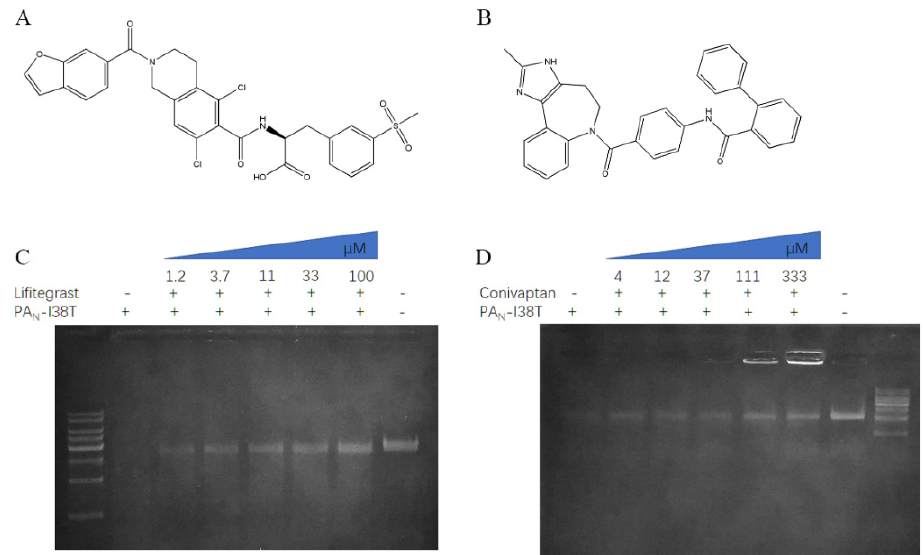
Figure 3. Inhibition of the endonuclease activity of PA N -I38T. The chemical structure of lifitegrast ( A ) and conivaptan ( B ). For the inhibition assay, different concentrations of compounds lifitegrast ( C ) and conivaptan ( D ) were incubated with the 1.5 μ M PA N -I38T and 100 ng M13mp18 at 37 °C for 1 h. After the digestion, the products were resolved on agarose gel. Table 1. IC 50 values of compound inhibited PA N and PA N -I38T endonuclease.